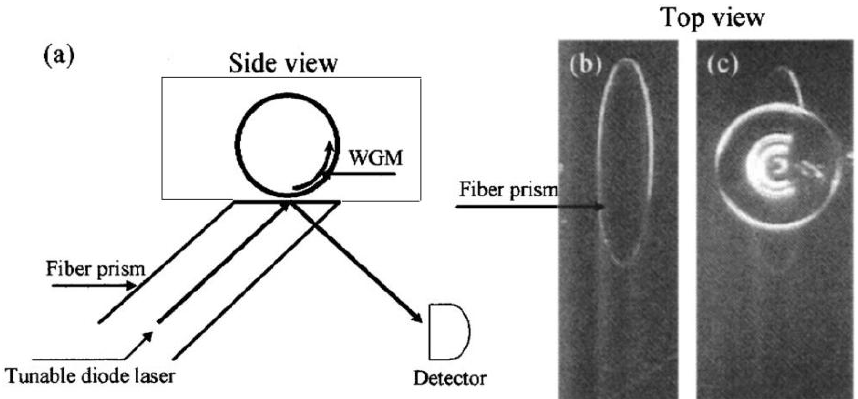
Figure 9. (a) Schematic of the microsphere and fluidic cell (side view); (b) top view of the fiber prism and of (c) the fused silica microsphere placed in contact with the fiber prism. Reprinted with permission from [38] © 2005, American Institute of Physics.